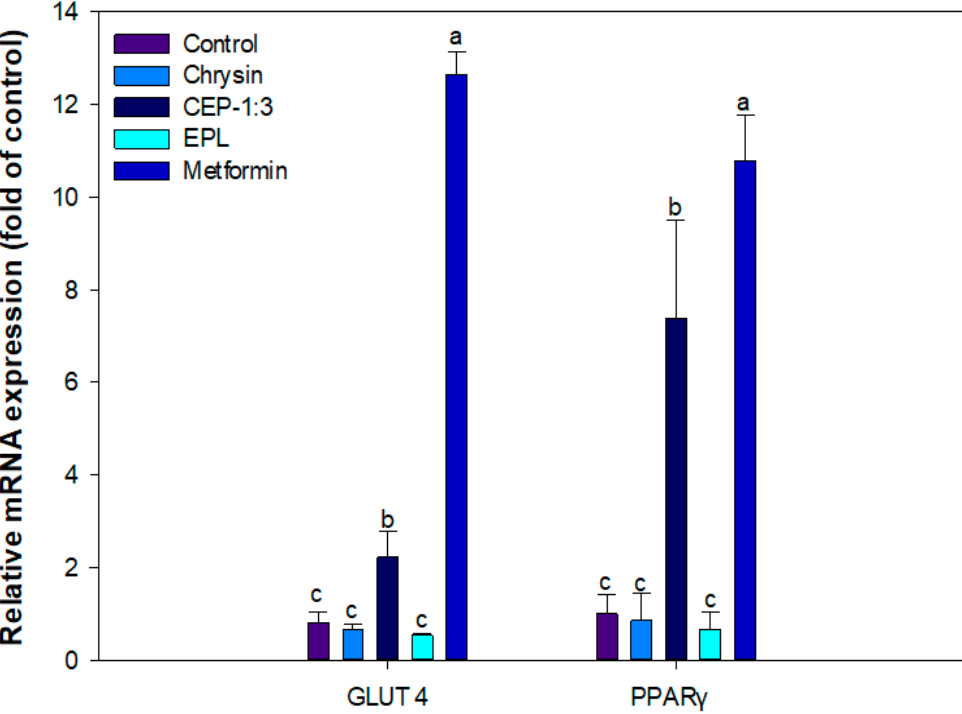
Figure 8. E ff ects of chrysin and CEP-1:3 on the expressions of PPAR γ and GLUT4 genes in C2C12 skeletal muscle cells . Chrysin and CEP-1:3 obtained after filtration of samples (equivalent to 1 mg / mL chrysin) through a 0.45 µ m syringe filter. The mRNA expression levels of PPAR γ and GLUT 4 genes were analyzed using qPCR and normalized to that of β -actin. Bars with di ff erent letters indicate significant di ff erences ( p < 0.05).